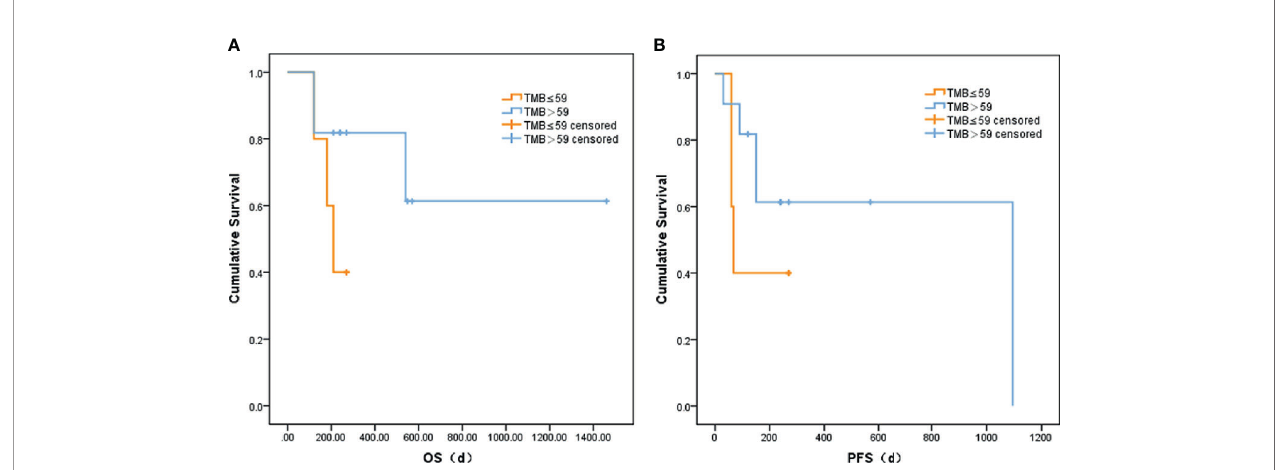
FIGURE 2 | Comparison of (A) OS and (B) PFS between liver cancer patients with different